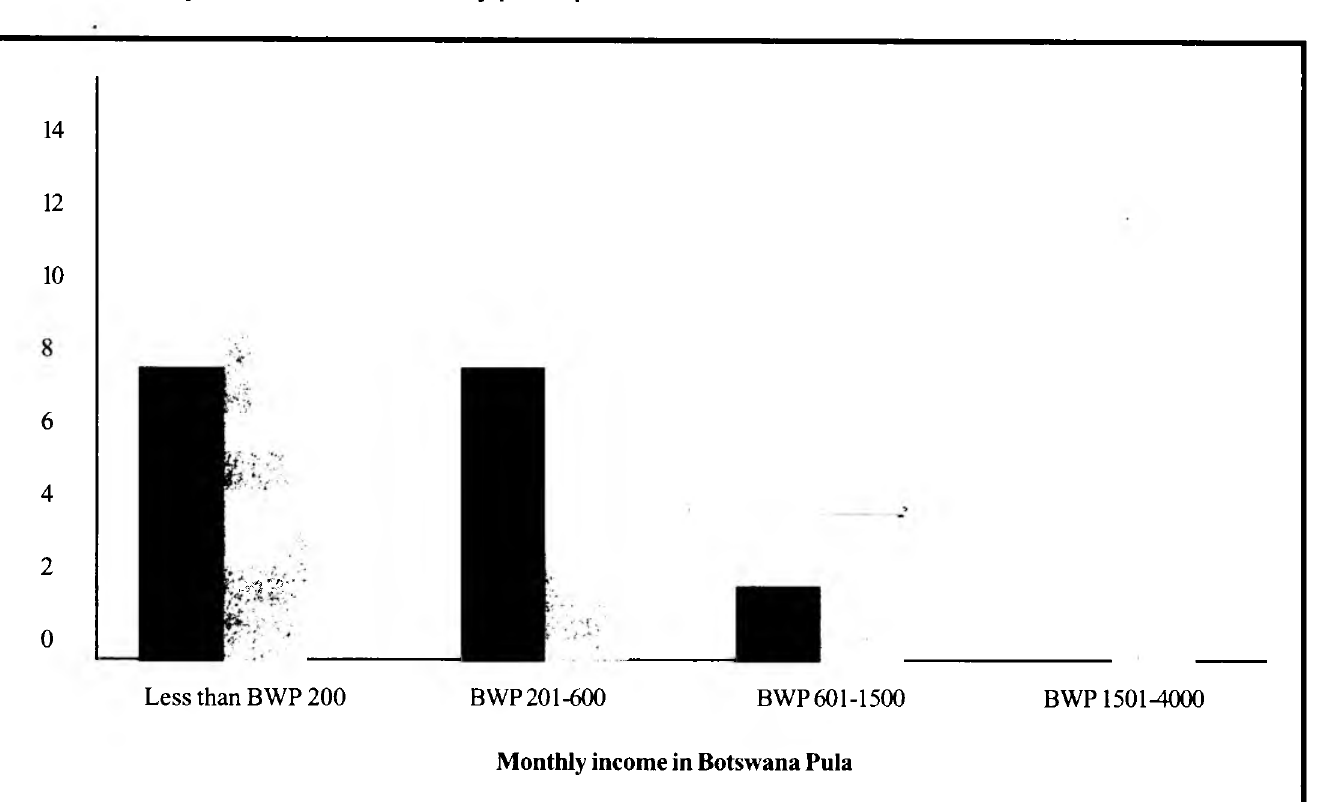
Figure 6 Monthly income of HIV+ve study participants with